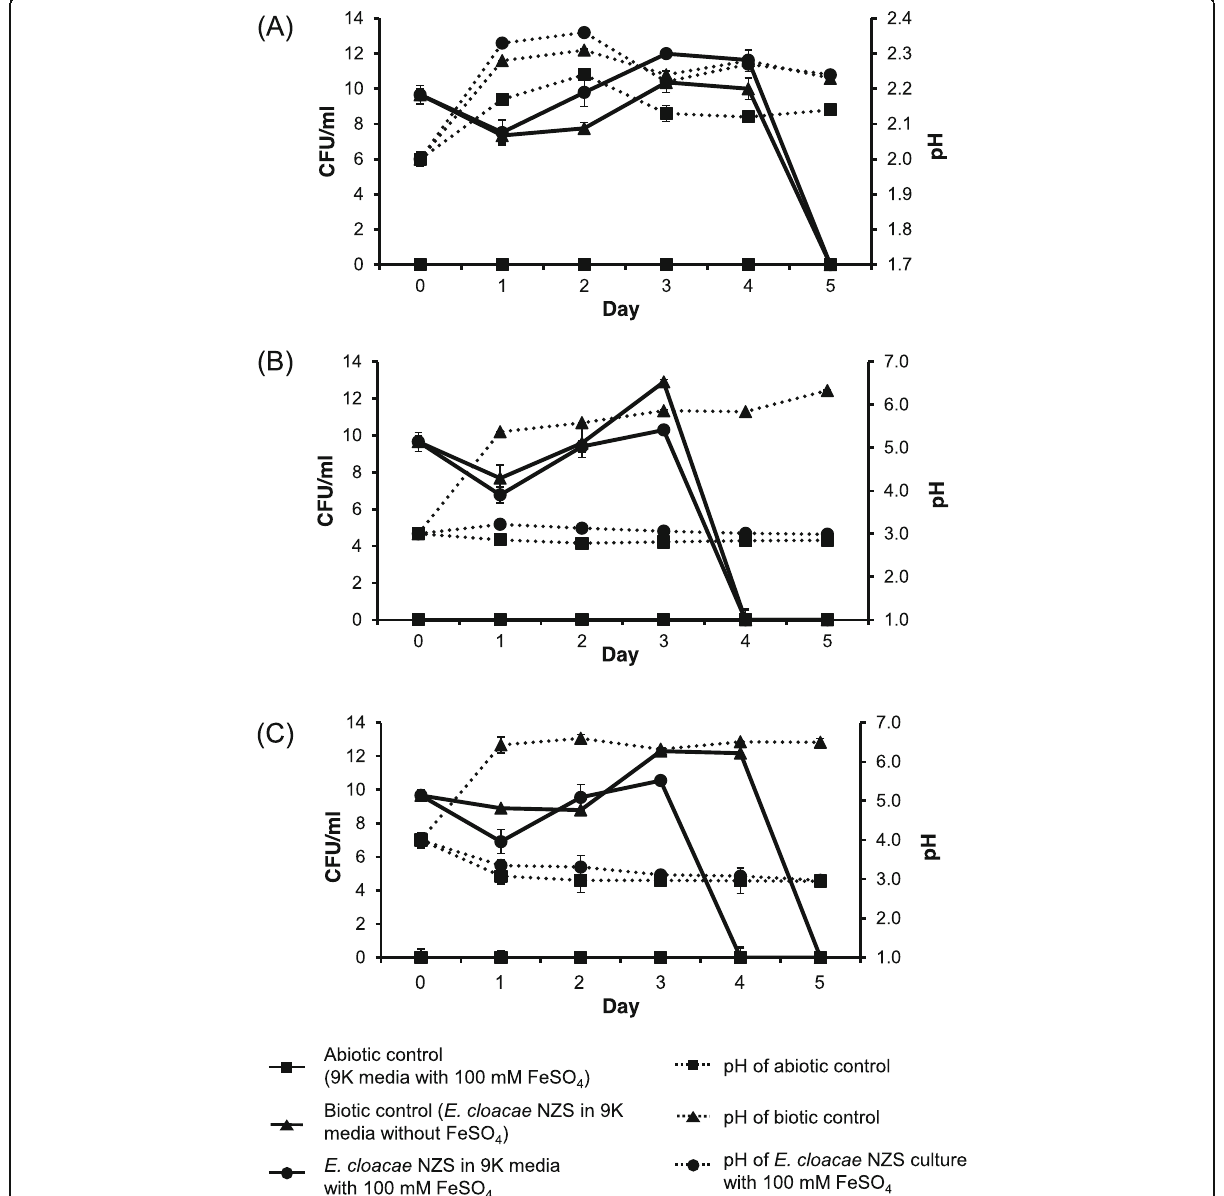
Fig. 3 Optimization of initial pH of 9K media at pH a 2, b 3, and c 4. No graph was plotted for 9K media with pH 1 as no bacterial growth was observed throughout incubation period. Cells were cultivated in 9K media containing 5g/L glucose with and without FeSO 4 , at 30 °C at 200rpm for